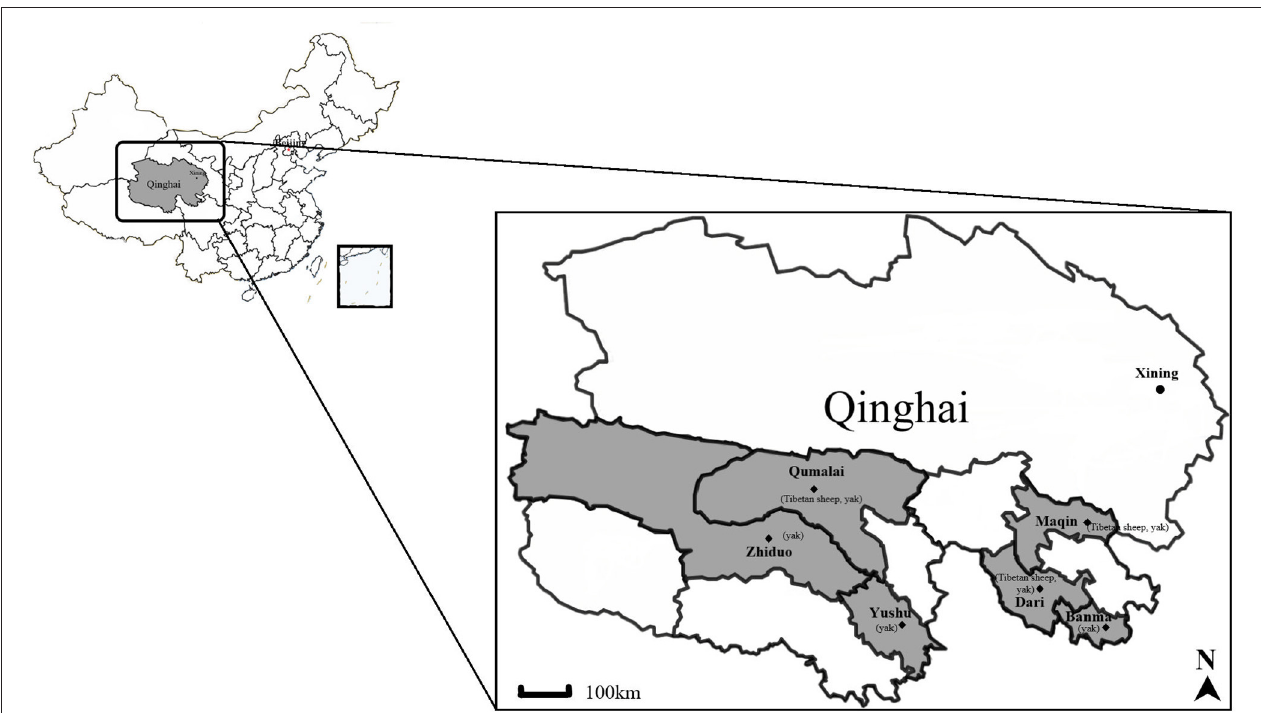
FIGURE 1 | Map of the Qinghai Province, showing the sampling sites and animals included. The yak and Tibetan sheep samples were collected at six sites indicated by (cid:7) . The figure was generated and modified using DITUHUI (https://g.dituhui.com). sites. The chi-square test was used to calculate the difference of infection rate in SPSS 25.0 software in each group. When p < 0.05, the difference was